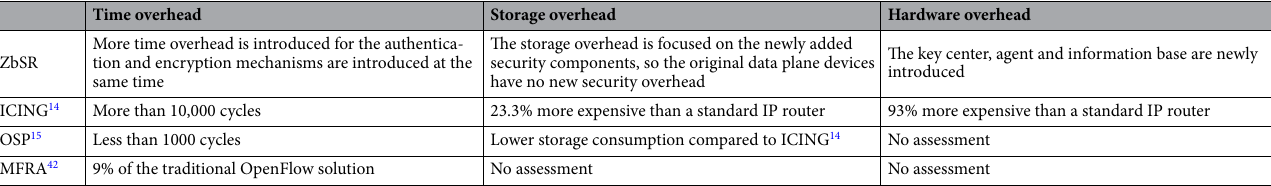
Table 7. Security overhead comparison of various security models.